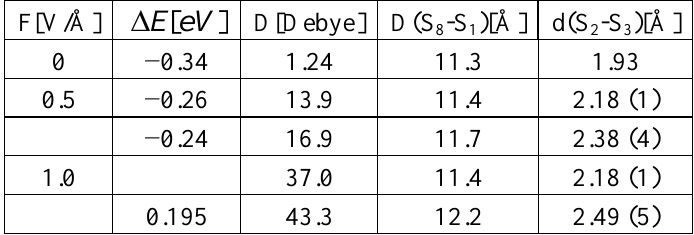
Table 1. Binding energies per sulfur atom, dipole moments and bond lengths for S function of field strength. ΔE is the difference in total energy of the cyclic minus the linear molecule per sulfur atom.